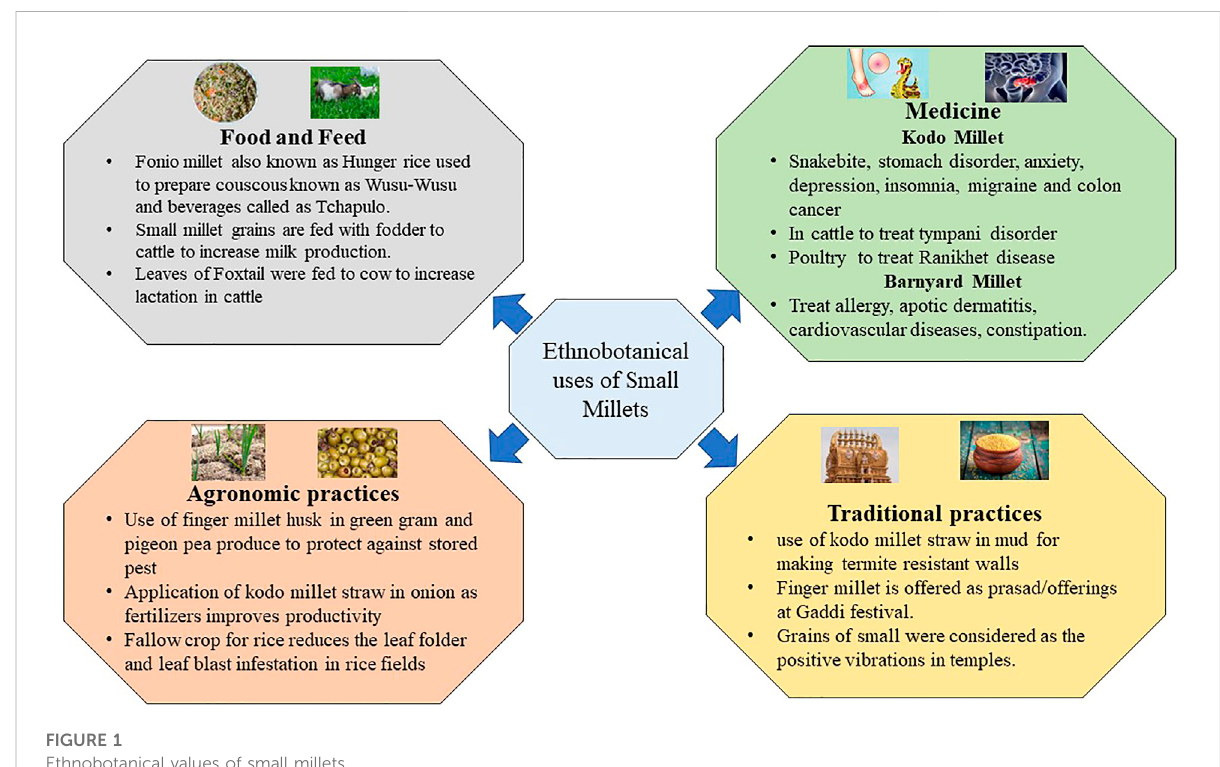
FIGURE 1 Ethnobotanical values of small